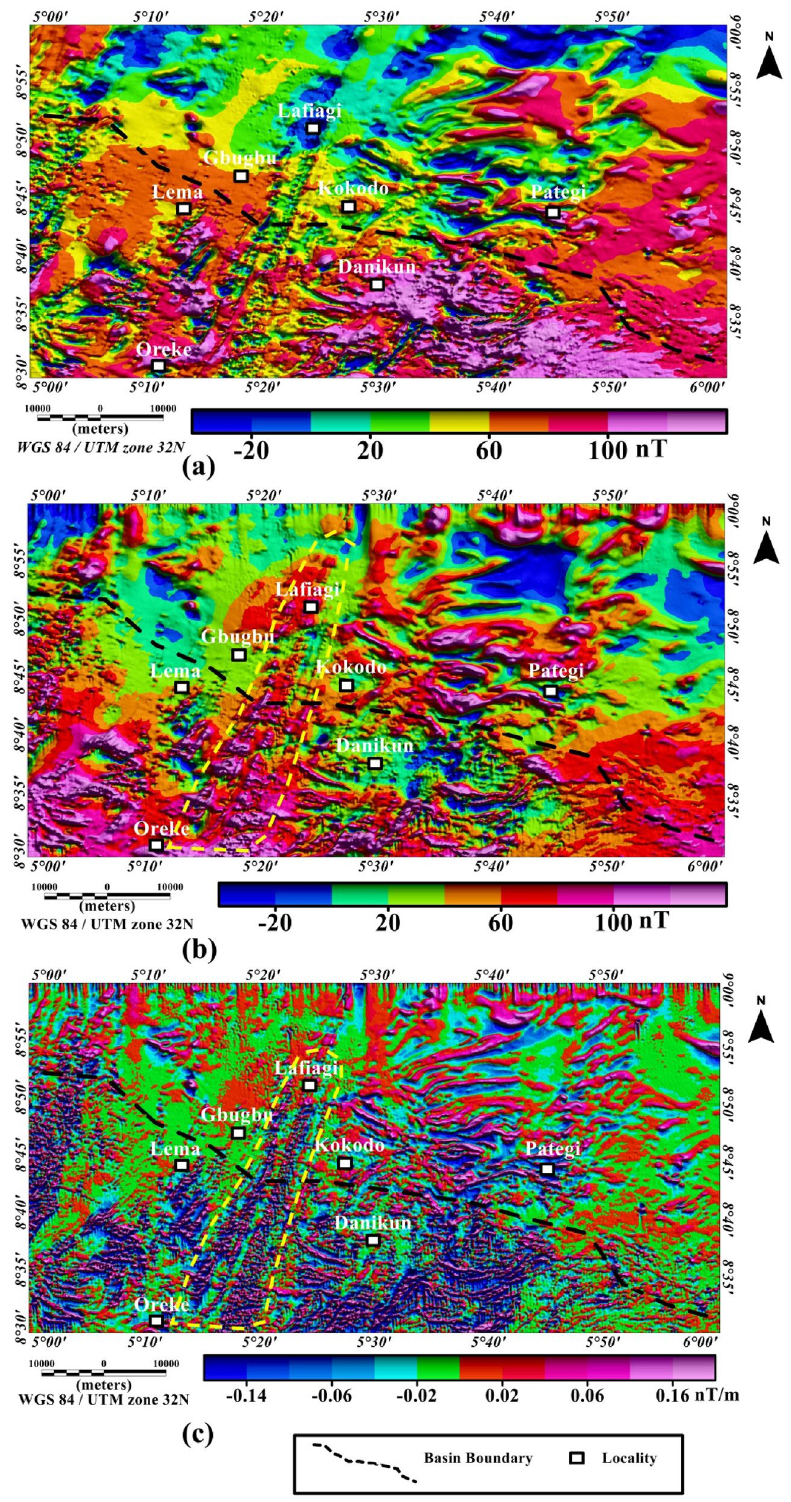
Figure 3. ( a ) Color-shaded residual magnetic intensity anomaly data, with color shading highlighting linear structural features especially at the central part of the study area. Note, at low-latitude regions such as the study area, magnetic sources are usually characterized by magnetic low anomalies. ( b ) Color-shaded reduced-to-pole (RTP) map computed from the residual total magnetic intensity data of the study area. The color shading highlights linear structural features which are shown in areas represented within the yellow dashed lines on the RTP map. ( c ) Color-shade first vertical derivative (FVD) map of the study area produced from the reduced-to-pole (RTP) residual magnetic intensity anomaly data. The RTP-FVD map reveals major linear structural features which are shown in areas represented within the yellow dashed lines on the map. The figures were produced using Oasis Montaj Software version 8.3.3 (Website: https:// www. seequ ent.